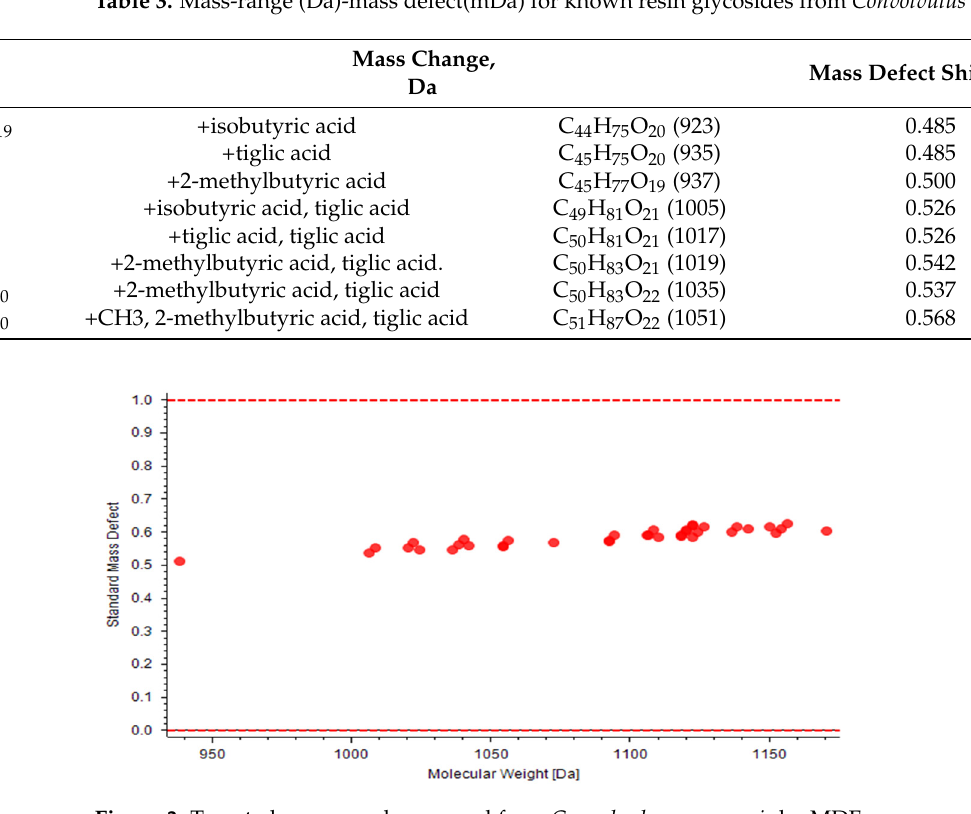
Figure 3. Targeted compounds screened from Convolvulus scammonia by MDF. Table 2. Transformations on resin glycosides.